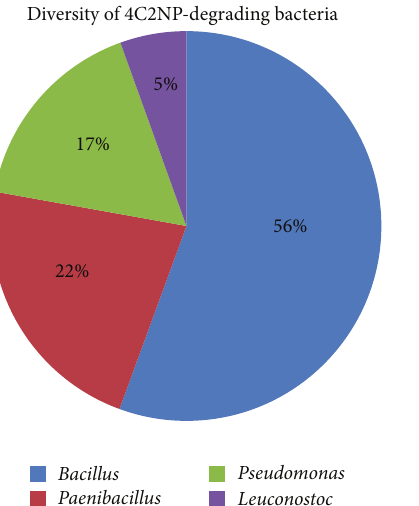
Figure 2: Diversity of 4-chloro-2-nitrophenol-decolorizing bacte- ria.